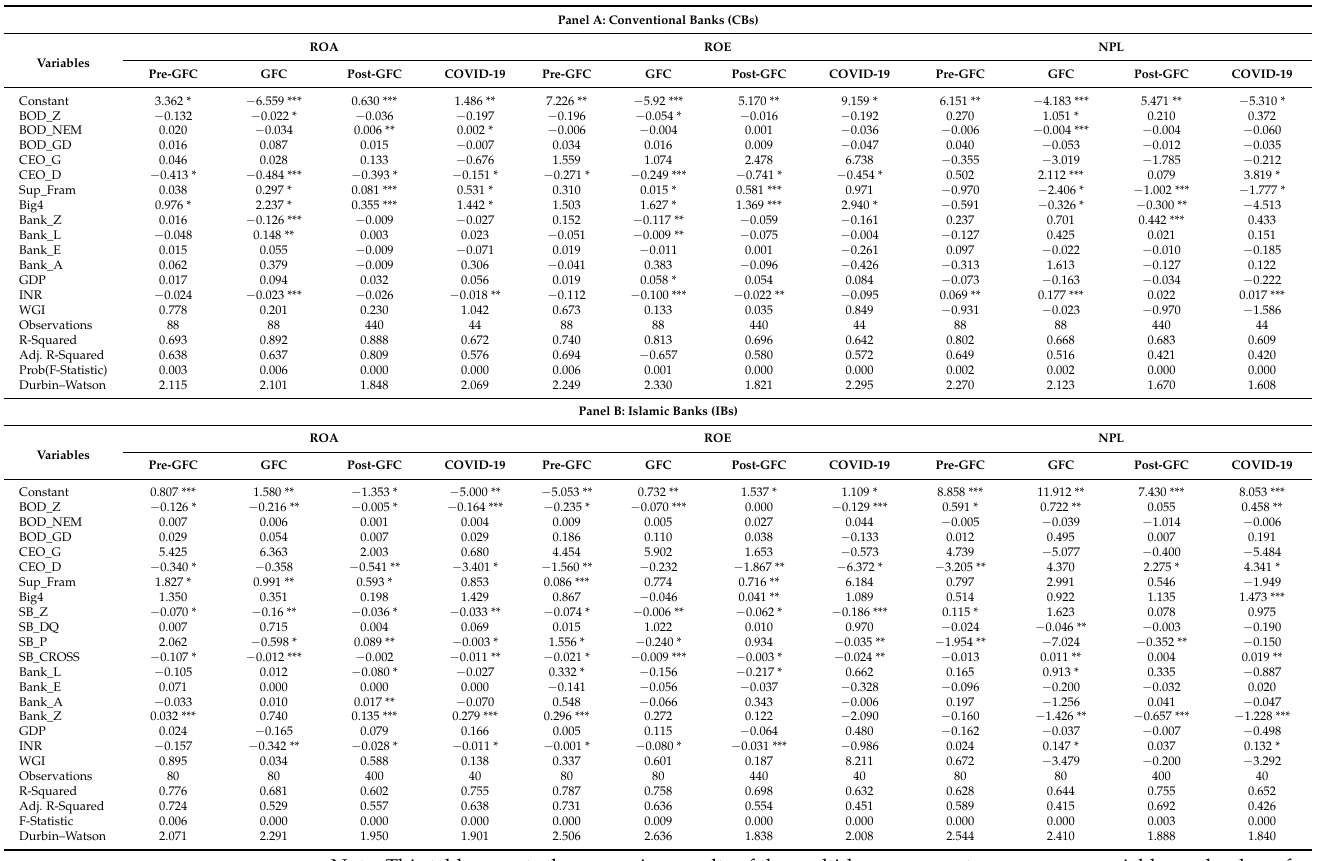
Table 6. Multi-layer corporate governance and bank performance: pre-GFC, GFC, post-GFC, and COVID-19